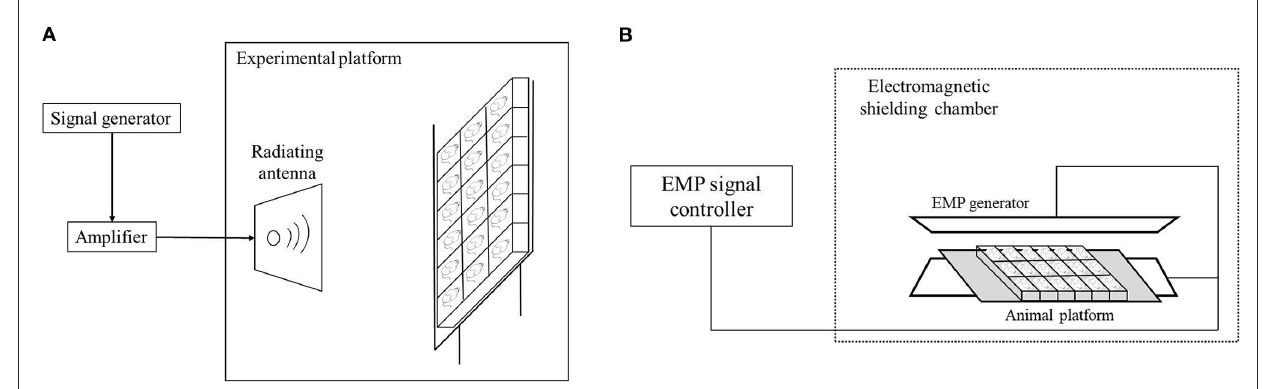
FIGURE1 Schematic illustration of exposure system setting. (A) RF exposure system set-up. (B) EMP exposure